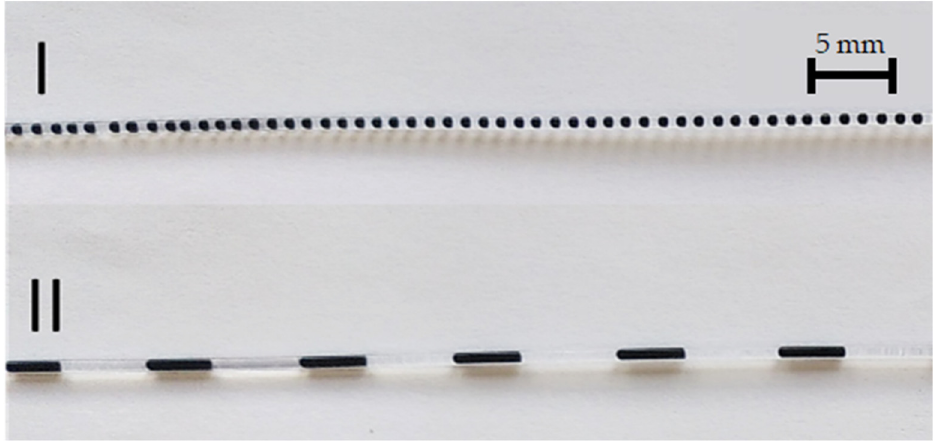
Figure 5. Slug flow in the capillary before ( I ) and after ( II ) the pump.